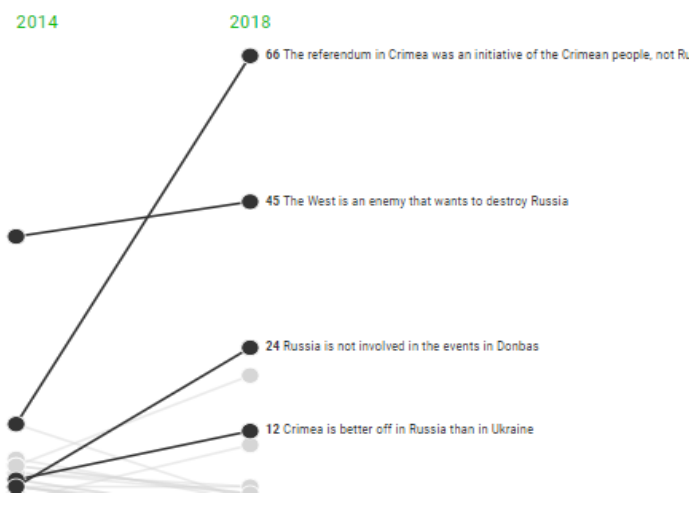
Figure 4: Storytelling Narratives about Crimea in Sputnik and RT, 2014-2018 (Source: Authors‟ depiction based on the registry of publications on the websites of both